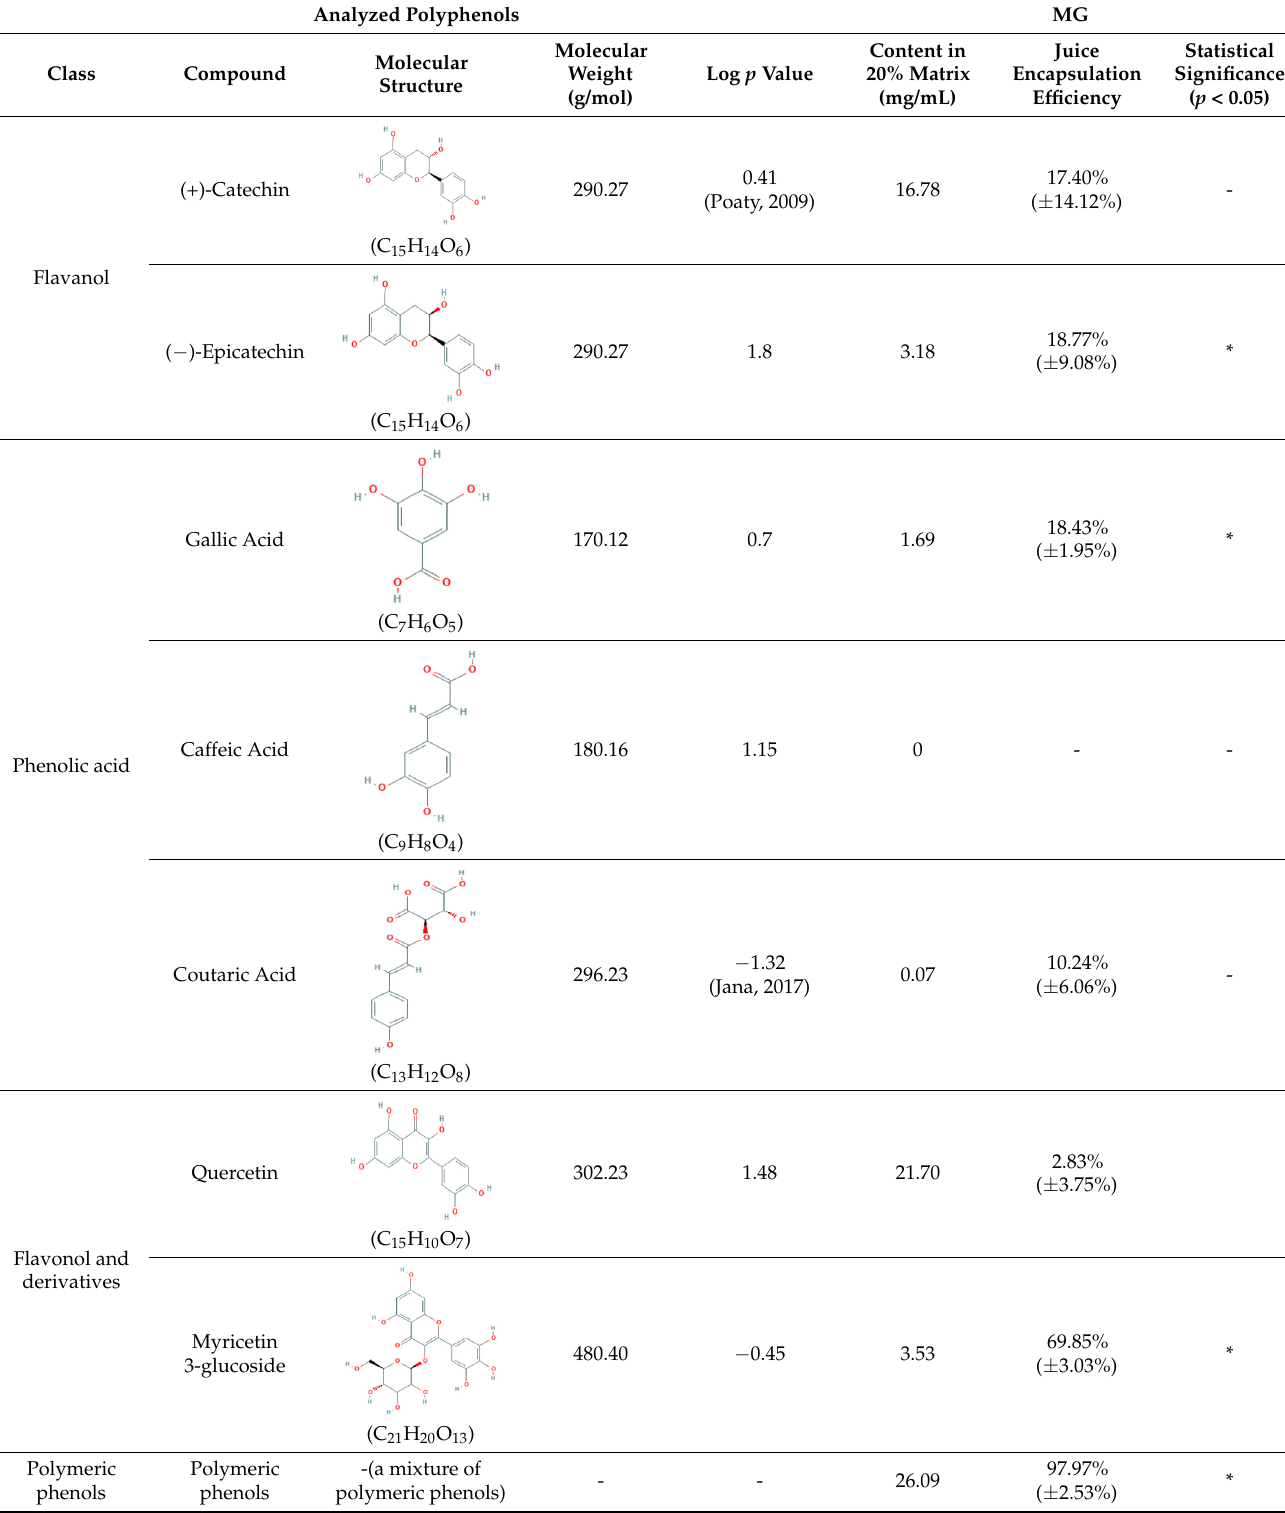
Table 2. Phenolic profile of MG juice encapsulated compounds in L. casei cell carrier.